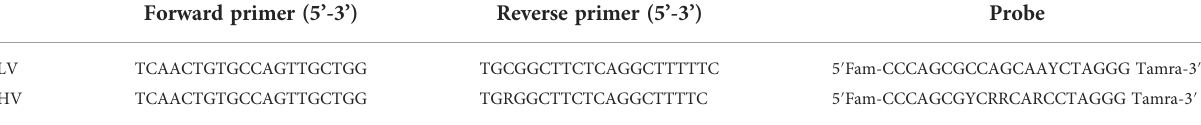
TABLE 2 Overview primers and probes used for PRRSV ORF7-speci fi c